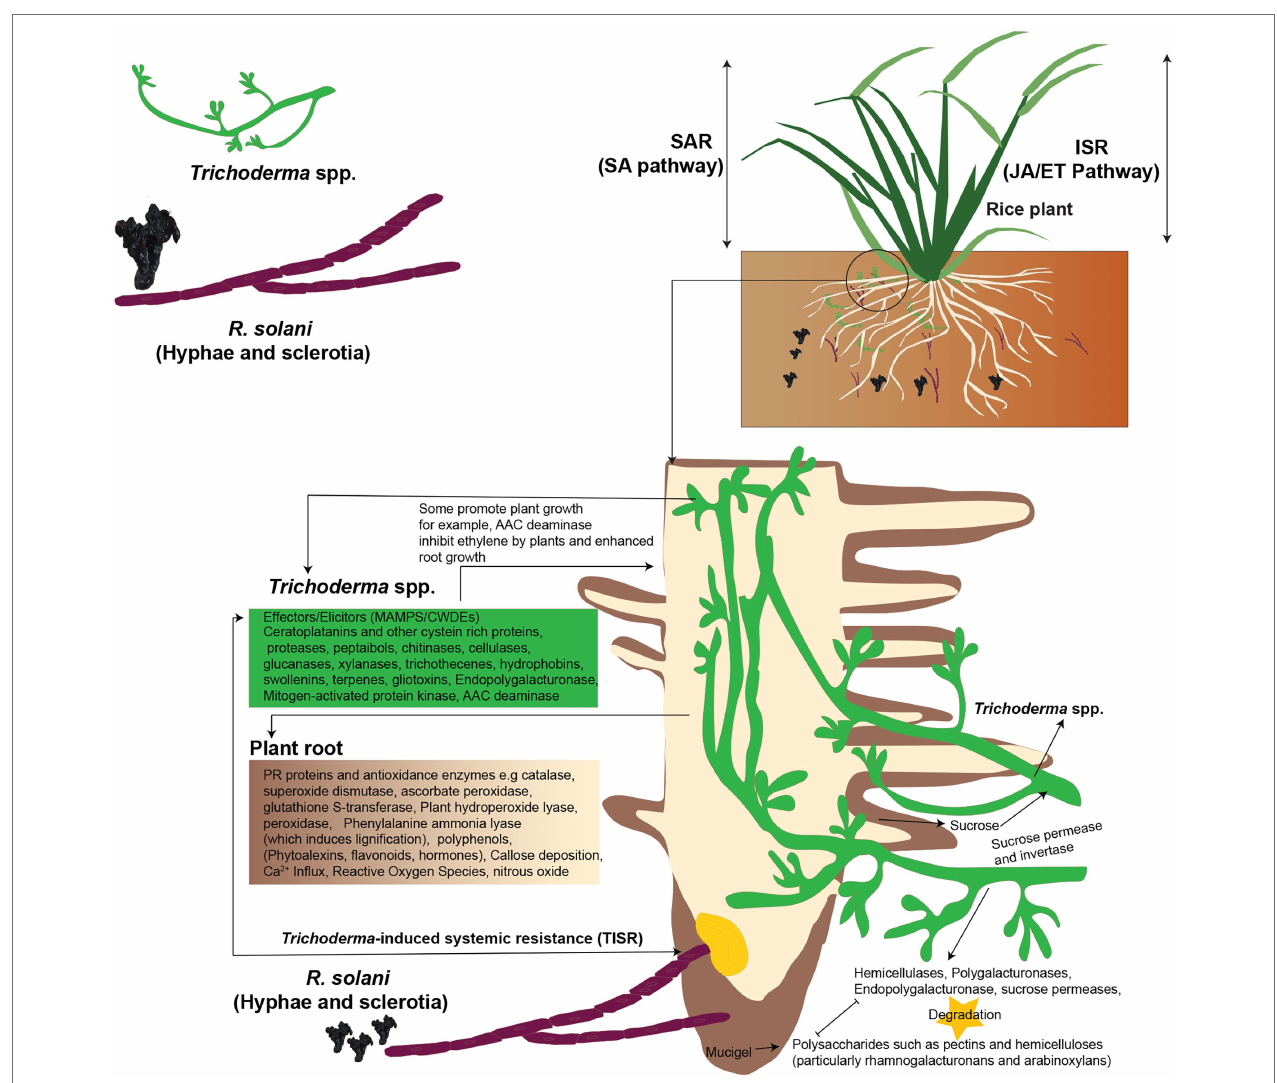
FIGURE 4 | Trichoderma -induced systemic resistance (TISR) in plants against R. solani . Both SA and JA/ET-mediated signal transduction pathways may trigger defensive responses against R. solani , boosting plant resistance. Trichoderma spp. release enzymes to degrade plant polysaccharides, colonize the roots, and take sucrose as a carbon source by using sucrose permease and invertase enzymes. Trichoderma spp. produce elicitors, such as MAMPs to induce TISR in the plants; plants synthesize hydroperoxide lyase, peroxidase, and phenylalanine ammonia-lyase (which induces lignification) and deposit callose. Trichoderma MAMPs, such as xylanase, elicits plant defense responses against R. solani . The 1-aminocyclopropane-1-carboxylic acid (AAC) deaminase inhibits ethylene formation by the plant, and this leads to enhanced root growth, and this is due to the formation of hormones. Besides, Trichoderma spp. attach to plants roots by producing hydrophobins and swollenin. Reconstructed from Druzhinina et al.